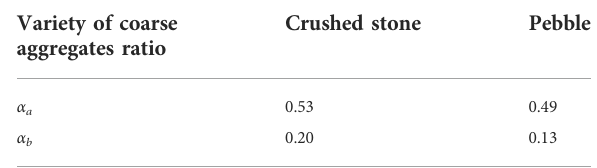
TABLE 7 Regression coef fi cient α a , α b value table. Variety of coarse aggregates ratio